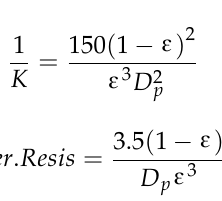
Figure 1. Solution domain for preliminary study.